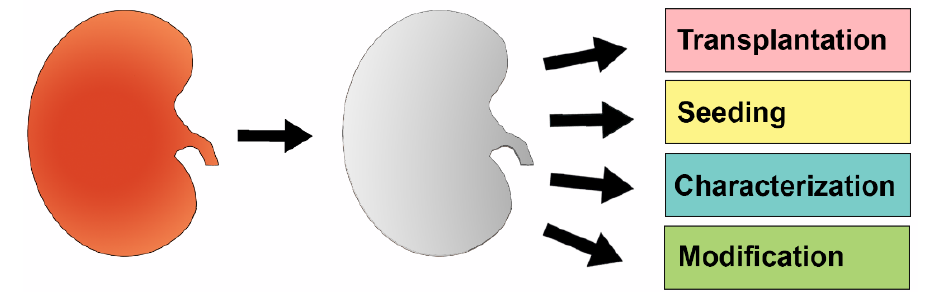
Figure 1. The Conceptual Basis and Application of Decellularized Kidney Scaffolds. An intact kidney (left, red) is first decellularized using agents such as detergent buffers. Once this process is complete, the resulting extracellular matrix (ECM) scaffold (middle, grey) can be manipulated in various ways, such as to be transplanted into a recipient or to undergo reseeding with new cells. Further, characterization of ECM proteins and chemical modification of the scaffold can also be performed.